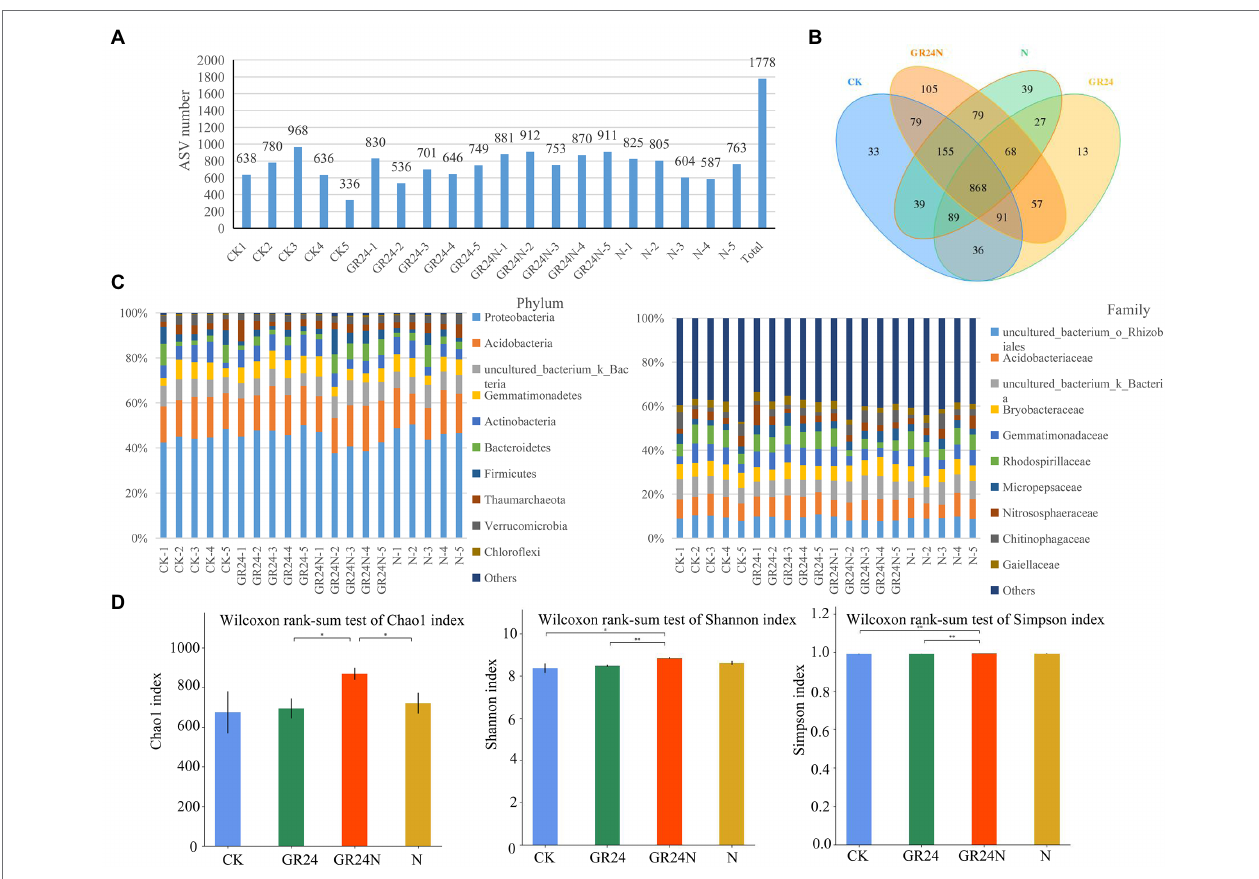
FIGURE 6 | Effects of additional N deposition and GR24 treatments on soil bacteria composition. (A) The number of ASVs obtained from each samples. ASVs were obtained by denoising the sequence using the dada2 method included in the QIIME2 software. (B) Venn diagram between treatments. (C) The histogram shows the species composition of soil bacteria in each sample (relative abundance at phylum and family levels). (D) Histogram of group differences in alpha diversity index. The significance of factors and the interaction between factors is marked at the top of the figure, where “ * ” represents p < 0.05 and “ ** ” represents p <